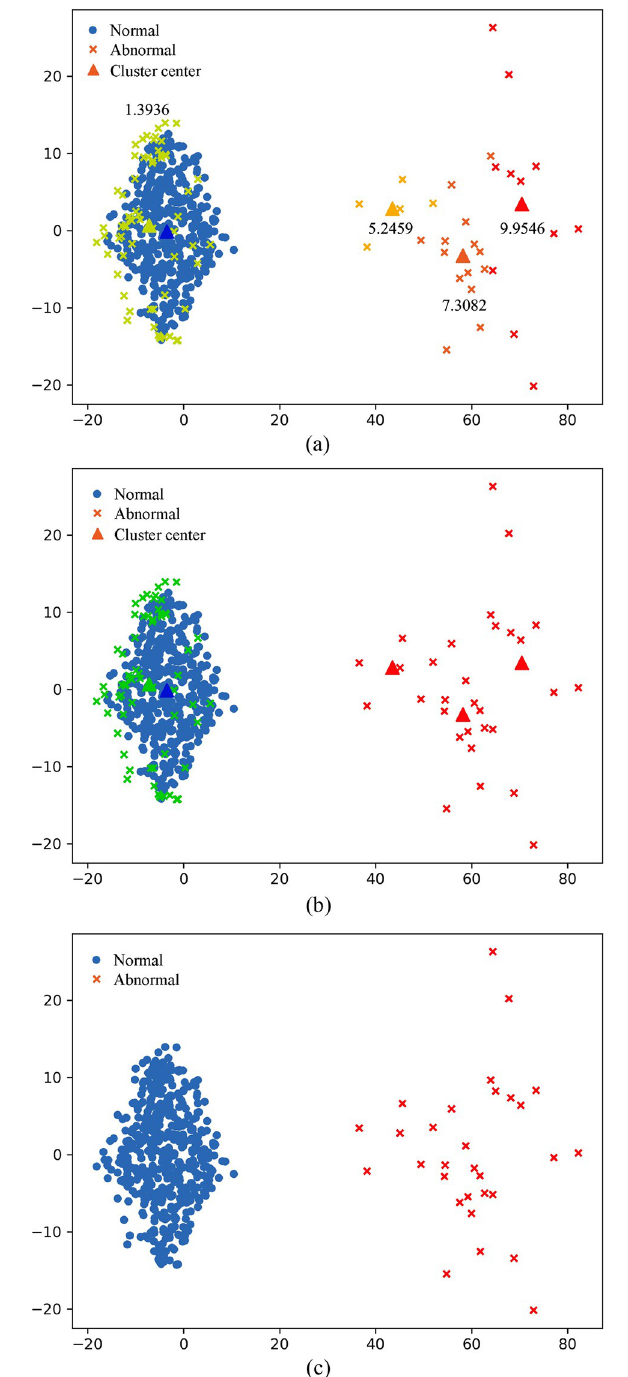
Fig 1. The result of X-means clustering on standard Euclidean distance from the abnormal cluster centers to the normal cluster center. (a): The result of K-Means clustering. (b): The final anomaly detection result of the generated data bu using X-iForest. (c): Demonstration of X-iForest on a test dataset.